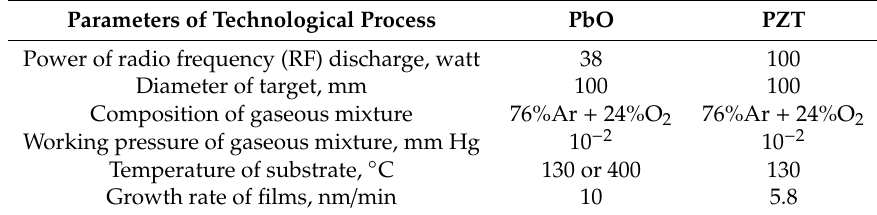
Table 1. Parameters of the deposition processes for PbO and lead zirconate-titanate (PZT) films. Parameters of Technological Process PbO PZT Power of radio frequency (RF) discharge, watt 38 100 Diameter of target, mm 100 100 Composition of gaseous mixture 76%Ar + 24%O 2 76%Ar + 24%O 2 Working pressure of gaseous mixture, mm Hg 10 − 2 10 − 2 Temperature of substrate, ◦ C 130 or 400 130 Growth rate of films, nm / min 10